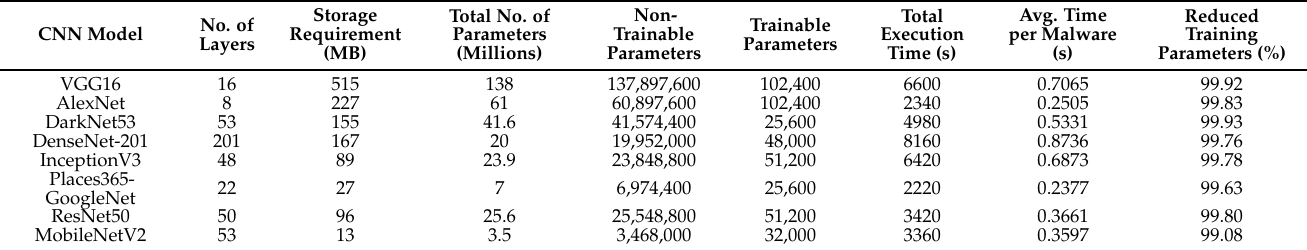
Table 8. Experimental specifications and execution time of the tested FT CNN-based TL models.